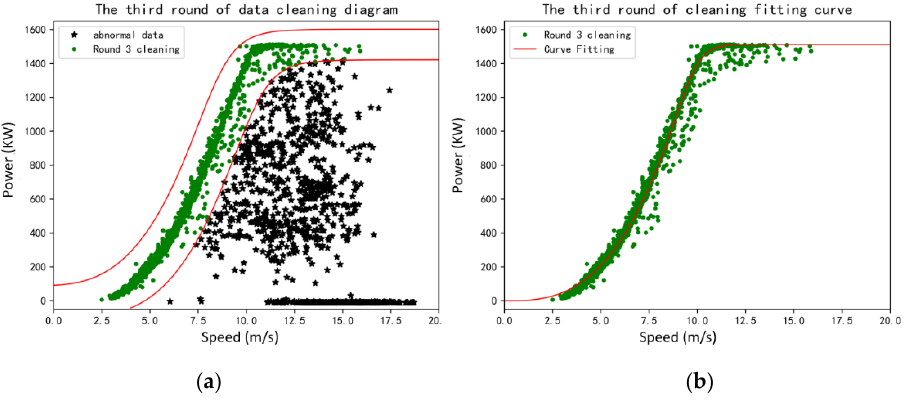
Figure 10. Same as Figure 8 but for the third round of data cleaning and power curve fitting. ( a ) The third round of data cleaning diagram; ( b ) the third round of cleaning fitting curve.